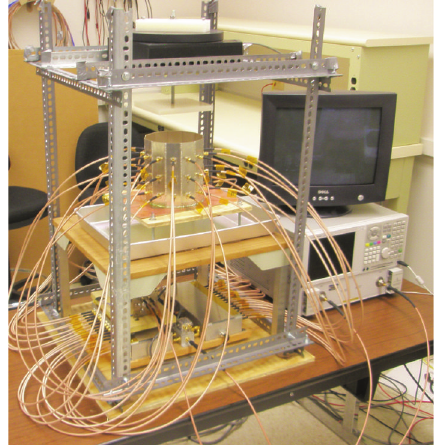
Figure 2: Breast imaging system prototype. The imaging cavity is connected to the VNA through a solid-state switching matrix. A rotator is mounted above and turns suspended objects for multiple transmitter views.